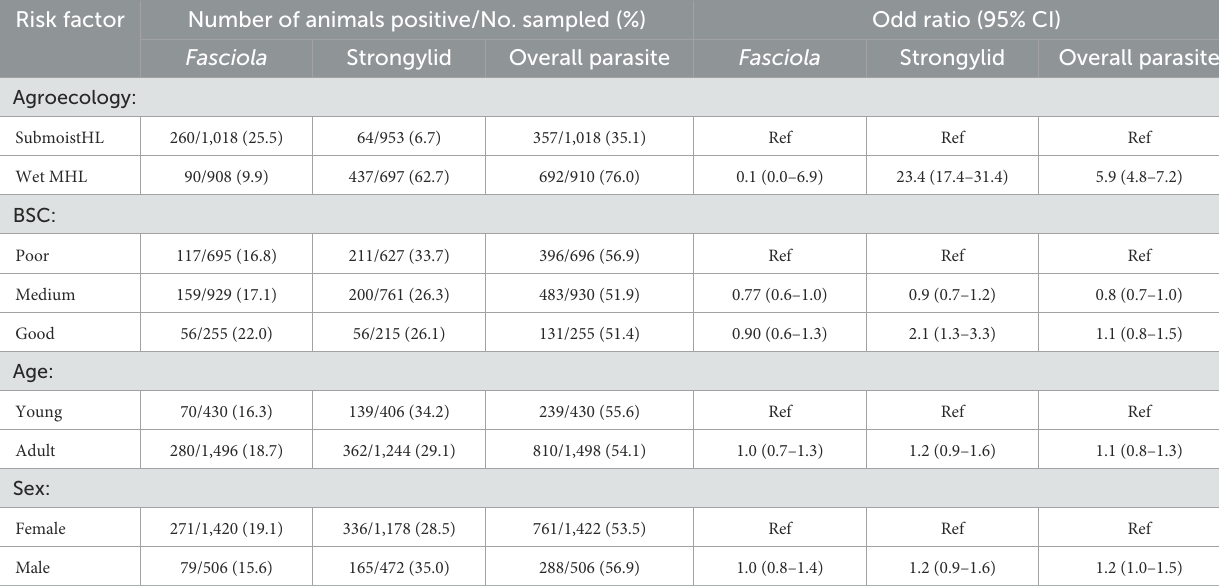
TABLE 5 Univariable category prevalence and mixed effect logistic regression analysis to screen the risk factors for the occurrence of Fasciola , strongylid, and any species of parasites taking district as random effect. Risk